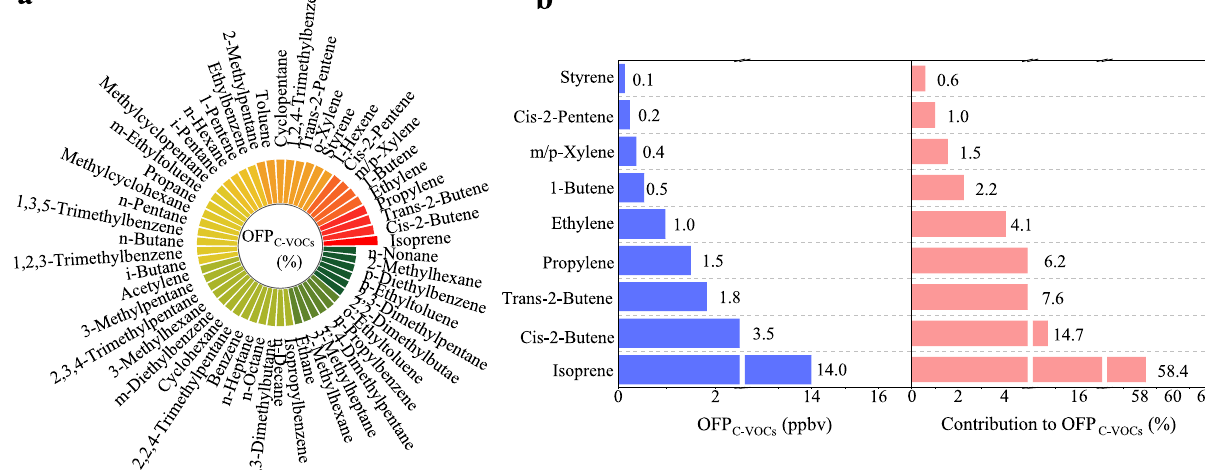
Fig. 4 OFP C-VOCs of different species were calculated. a OFP C-VOCs (OFP calculated based on C-VOCs) importance ranking of all volatile organic compounds; b OFP C-VOCs of the top nine reactive species and their percentage contributions to OFP C-VOCs . This fi gure illustrates that reactive VOCs species should be valued for their participation in chemical